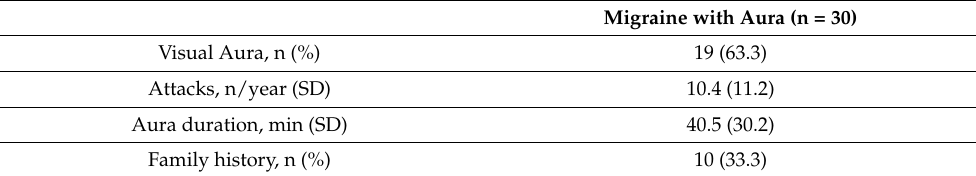
Table 1. Aura characteristics of MA patients.